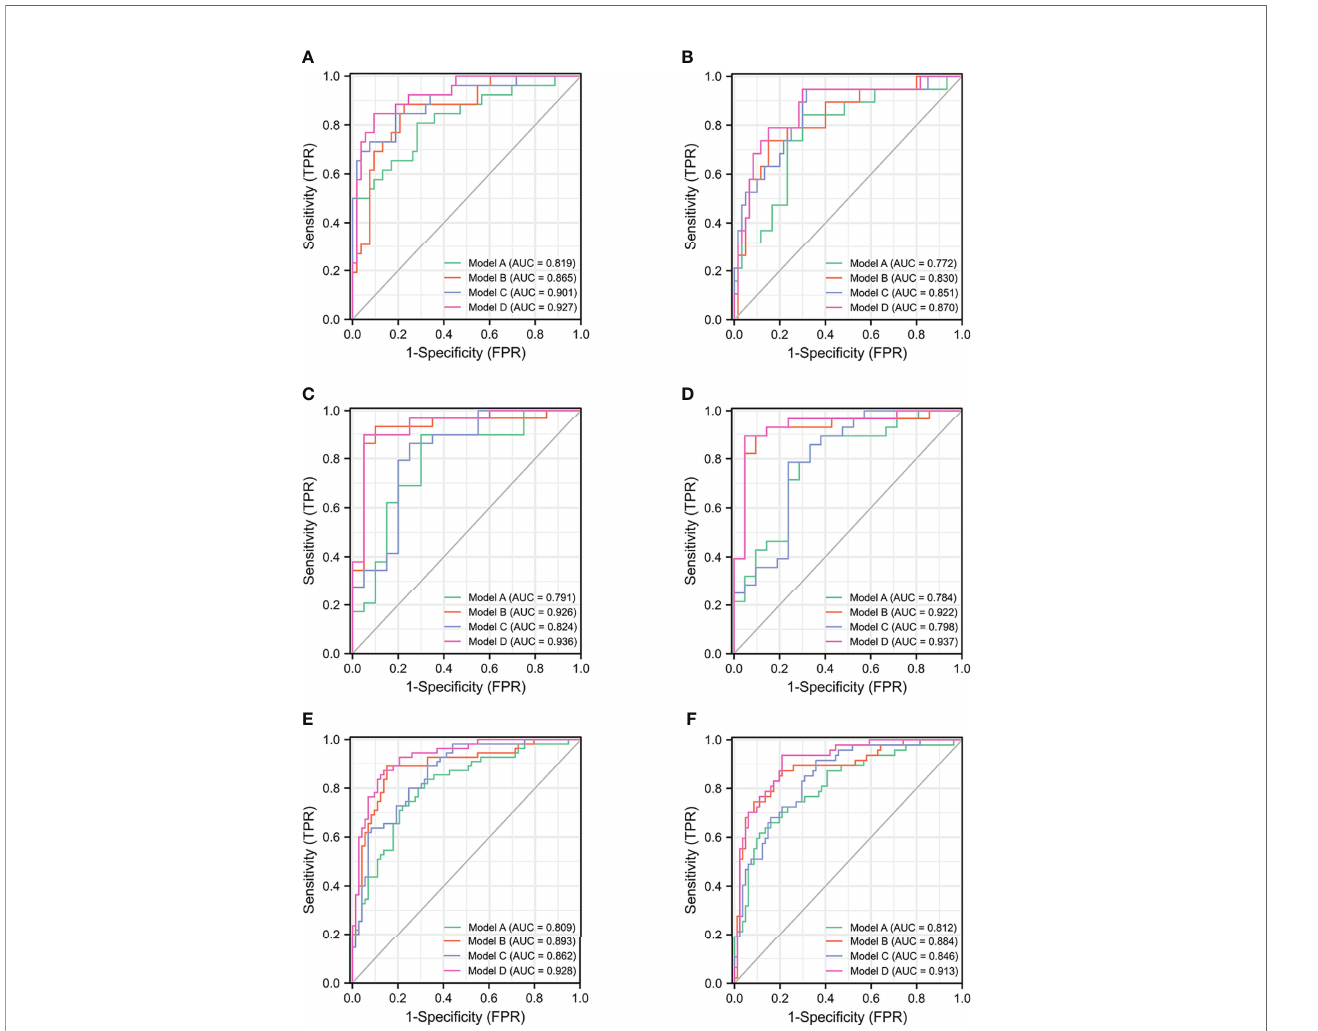
FIGURE 1 | The ROC curves of models for PCa and CSPCa. (A) The models for PCa in TPSA 4 – 10 ng/ml. (B) The models for CSPCa in TPSA 4 – 10 ng/ml. (C) The models for PCa in TPSA 10 – 20 ng/ml. (D) The models for CSPCa in TPSA 10 – 20 ng/ml. (E) The models for PCa in TPSA 4 – 20 ng/ml. (F) The models for CSPCa in TPSA 4 – 20 ng/ml. Model A: multivariable model based on the TPSA derivatives (base model); Model B: multivariable model based on the combination of PHI derivatives and base model; Model C: multivariable model based on the combination of the PI-RADS and base model; Model D: multivariable model based on the combination of PHI derivatives and